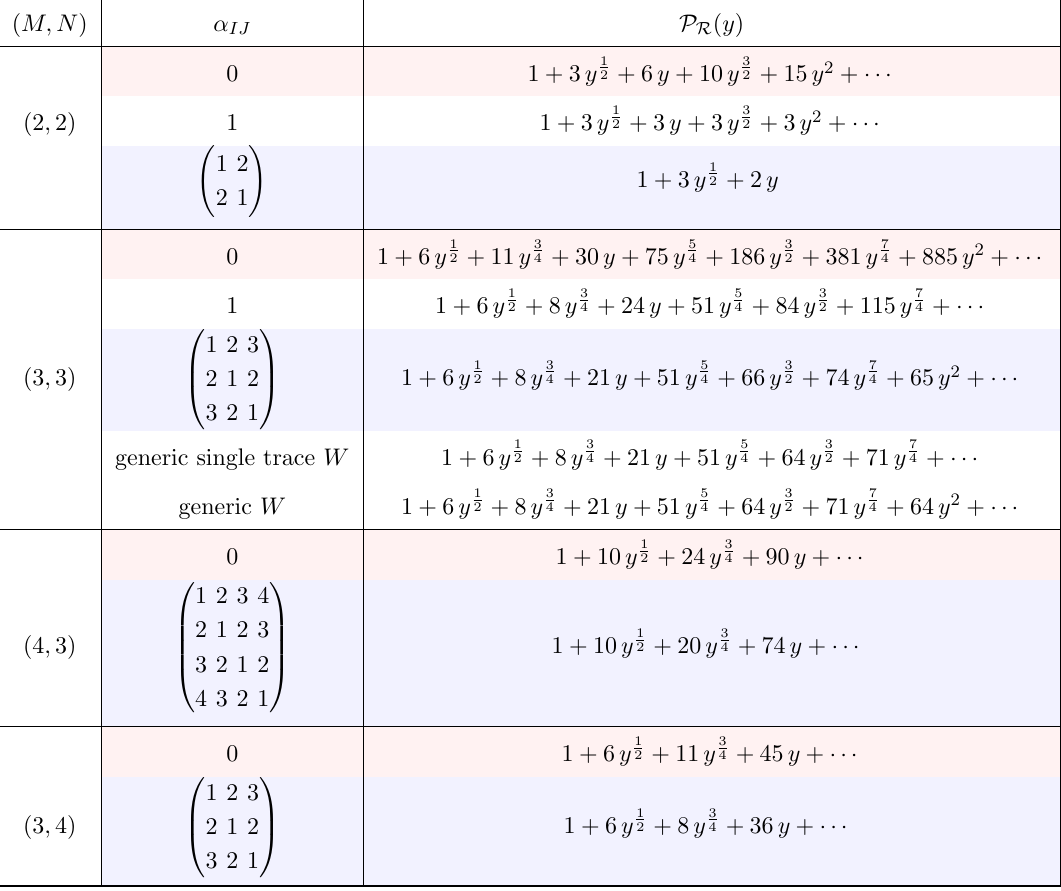
Table 6 . Higgs branch chiral ring Poincar(cid:18)e polynomial for various choice of (cid:11) IJ . We have high- lighted the results for the free theory and the anisotropic model for ease of